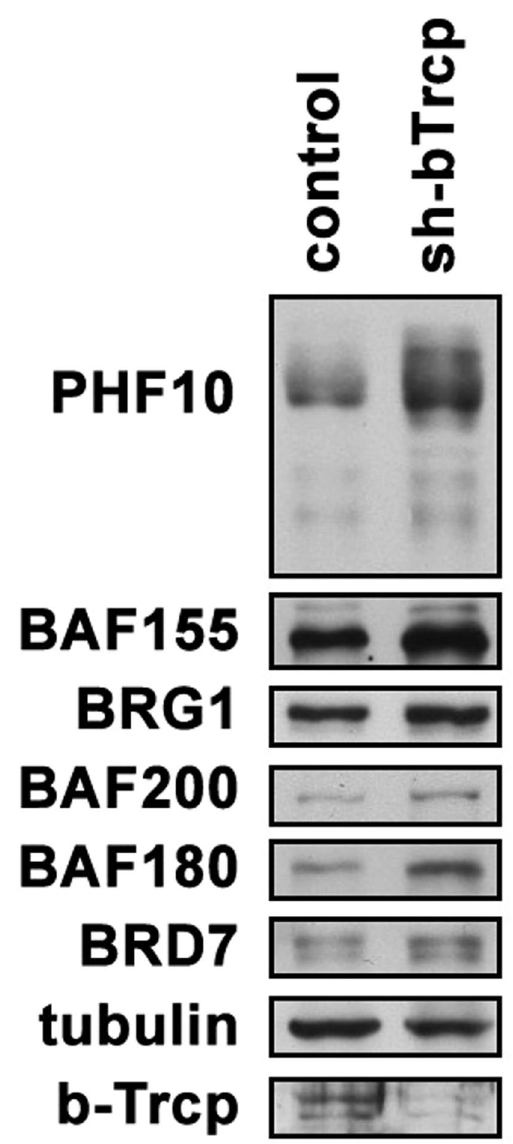
Figure 4. The influence of β -TrCP knockdown on the level of PBAF subunits. ( A ) HEK293 were transfected by sh- β -TrCP-pSuper and control empty vector. Two days later cells were lysed and the level of PBAF subunits was analyzed by Western blot using the indicated antibodies. Tubulin was used as loading control. The lower panel demonstrates the level of β -TrCP knockdown. The image is